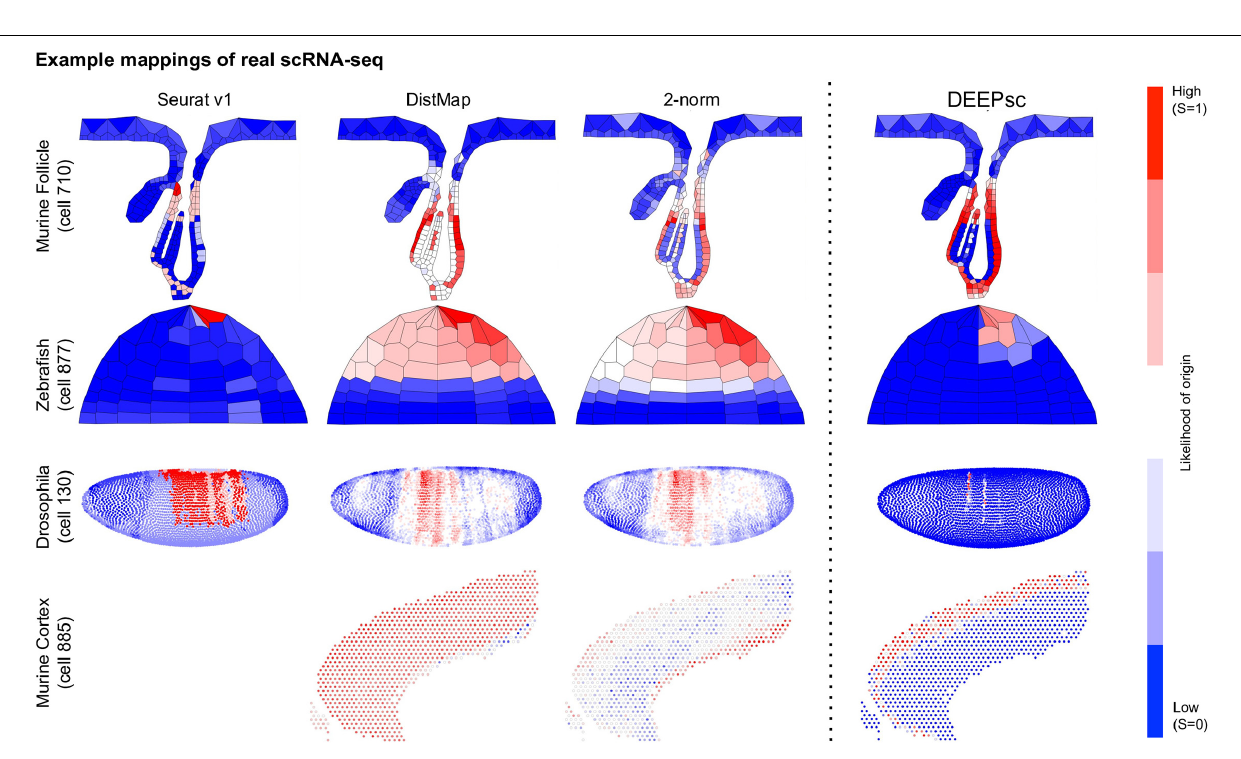
Frontiers in Genetics |